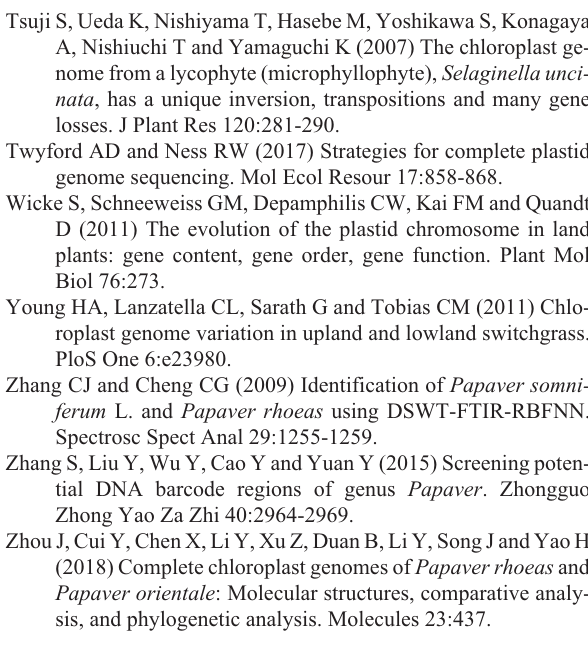
species used in comparative chloroplast genome analyses. Table S2 - The variable sites information of seven chloro- plast (cp) regions between P. somniferum and P. setigerum